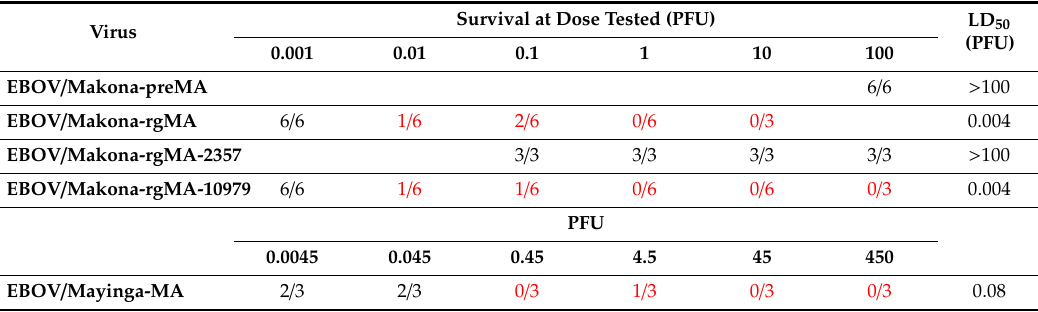
Virulence comparison of mouse-adapted EBOV / Makona viruses to mouse-adapted EBOV-Mayinga. Groups of 4 to 6 week old BALB / c mice ( n = 3 to 6) were infected by intraperitoneal injection with either EBOV / Makona-preMA, reverse genetics generated EBOV / Makona-MA (EBOV / Makona-rgMA), EBOV / Makona-MA with either the 2357 mutation (EBOV / Makona-rgMA-2357) or the 10,979 mutation (EBOV / Makona-rgMA-10979), or EBOV / Mayinga-MA with various doses shown in plaque forming units (PFU). Survival and weight loss were monitored for up to 18 days post-infection. Median lethal dose (LD50) was calculated using the Reed and Muench method. Survival at Dose Tested (PFU) LD 50 Virus (PFU)